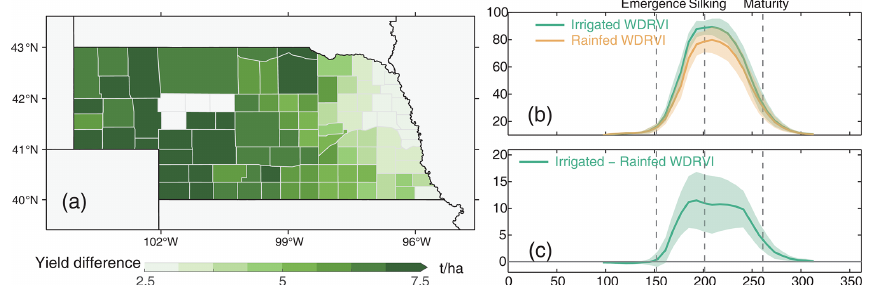
Figure 2. The difference between irrigated and rainfed maize yield (a) and satellite-observed vegetation index (b, c) . The shaded area in (b) and (c) shows 1 standard deviation of the WDRVI (b) and WDRVI difference (c) .